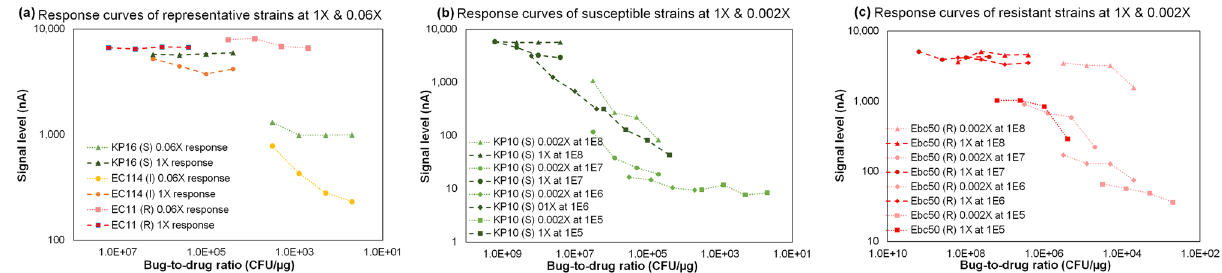
Figure 1. Specimen dilution configurations of ( a ) 1×/0.06× with representative S, I, and R strains; ( b ) 1×/0.002× with representative S strains, and ( c ) 1×/0.002× with representative R strains. Each error bar represents 2–4 data points.